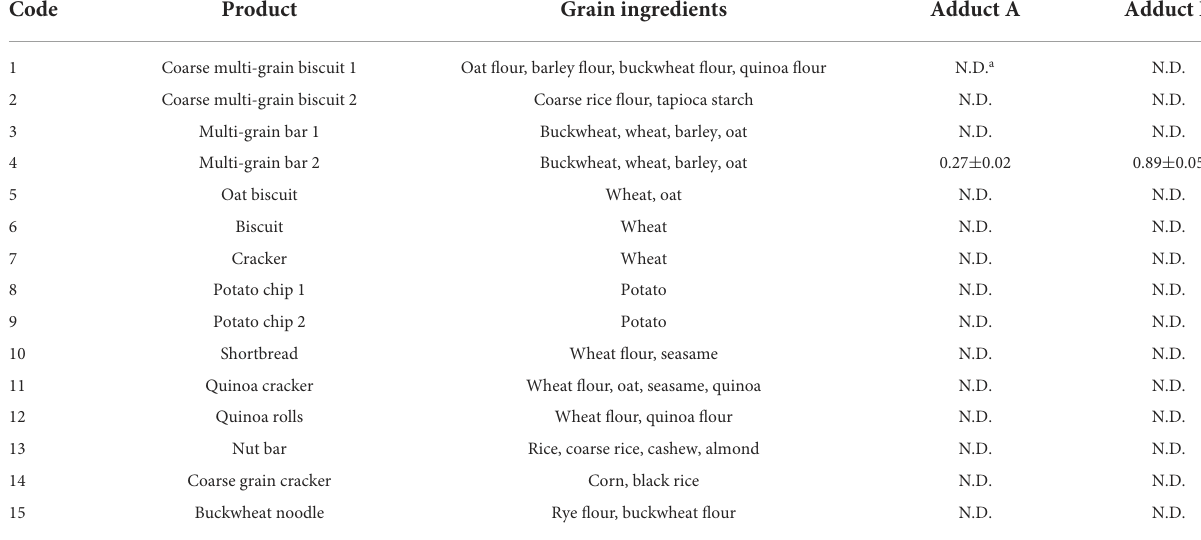
TABLE 2 Contents (mg/kg) of adducts A and B in commercial food